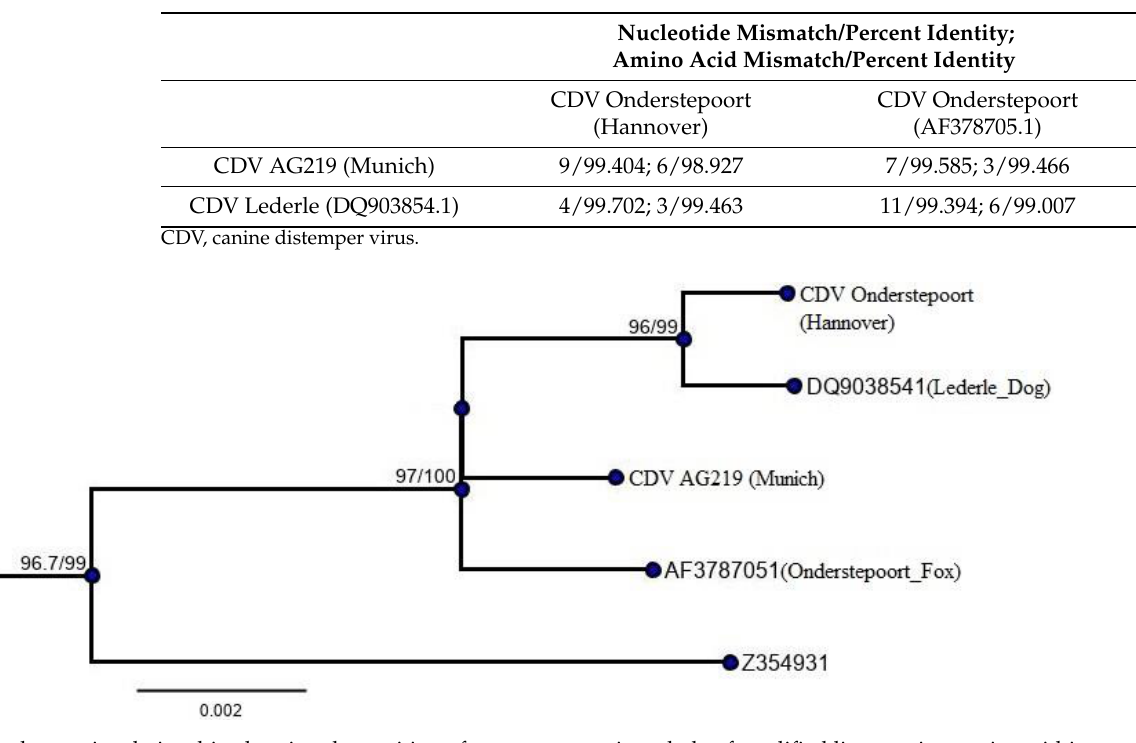
Figure 1. Phylogenetic relationship showing the position of test sequences in a clade of modified live vaccine strains within America-1 lineage. For key nodes, support values are labeled as bootstrap (BS)/posterior probability (PP).